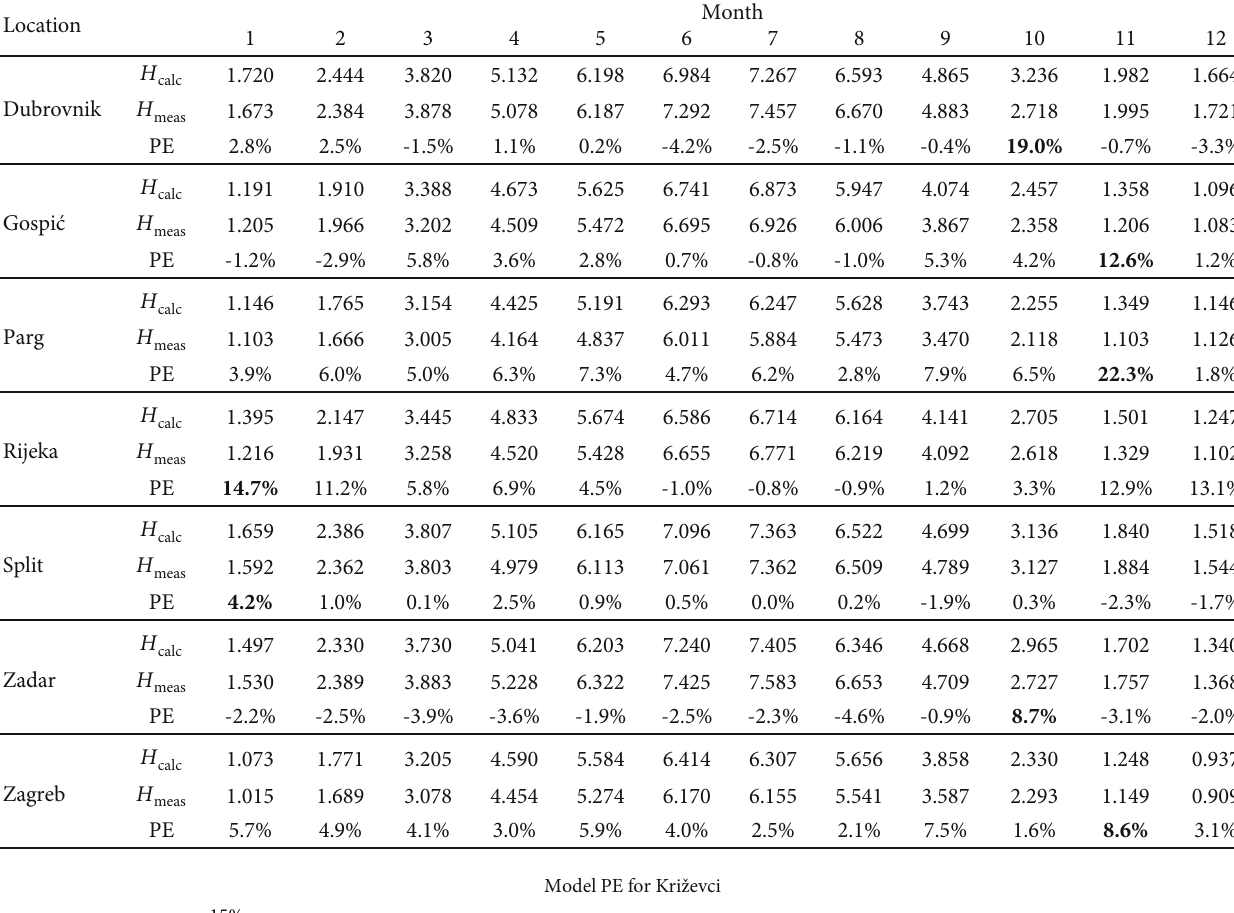
and H are in kWh/m 2 . calc meas